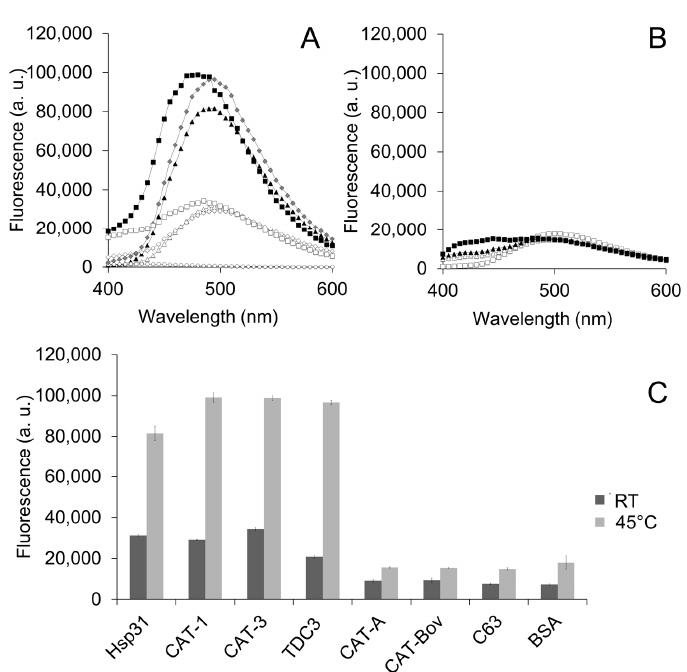
Figure 2. Hydrophobic regions at the CT are exposed by temperature. ( A ) Fluorescence of the bis-ANS (1.2 µM) when it binds to the hydrophobic zones of the protein surface. CAT-1, CAT-3, and TDC3, together with the Hsp31 (each at 0.8 µM) presented fl uorescence at RT which increased 3- fold when incubated at 45 °C for 30 min. Hsp31 (open triangles at RT; closed triangles at 45 °C), CAT-3 (open squares at RT; closed squares at 45 °C), and TDC3 (open rhomboids at RT; closed rhomboids at 45 °C). ( B ) The SSC CAT-A and BSA showed a low fl uorescence and a small increase with temperature. CAT-A (open squares at RT; closed squares at 45 °C) and BSA (open triangles at RT, closed triangles at 45 °C). ( C ) Average of highest values of three independent experiments. To assure that the exposed hydrophobic regions that interact with bis-ANS are in- volved in the unfolding activity, the bis-ANS, by UV light treatment, was covalently bond to its binding residues. Proteins treated with bis-ANS plus UV light lost the ability to in- hibit heat denaturation of ADH (Figure 3A,B). The mere presence of bis-ANS, added 10 min after initiation of the reaction, also hampered the unfolding activity (Figure 3C).